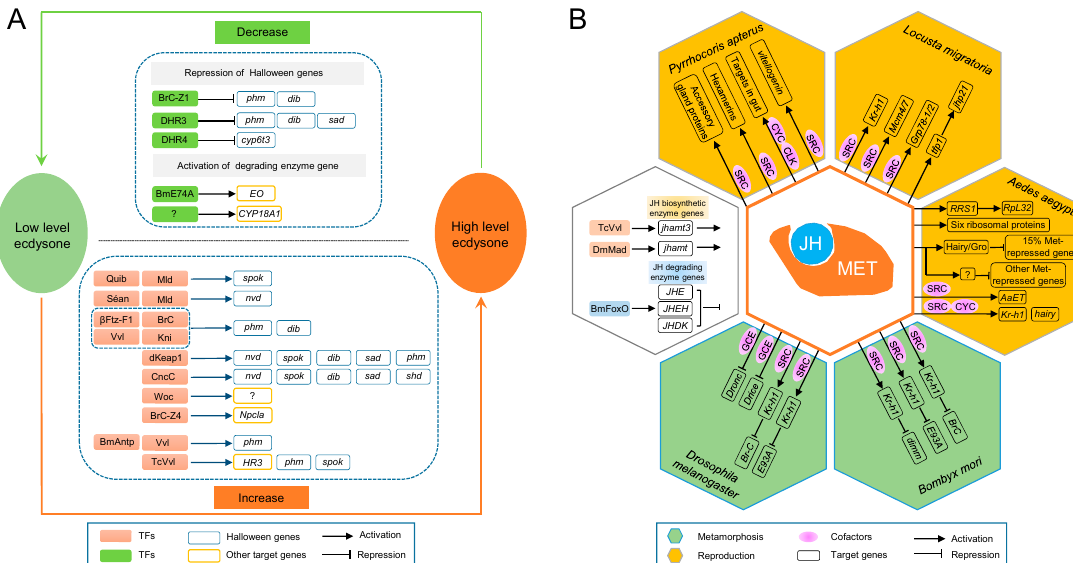
Figure 4. The 20-hydroxyecdysone (20E) and juvenile hormone (JH) signaling pathways regulating insect molting, metamorphosis, and reproduction. ( A ) Regulation of ecdysone titer by TFs. Changes in the ecdysone titers of insects are synergistically controlled by the synthesis and degradation of ecdysone. A low level of ecdysone promotes TFs to specifically regulate the Halloween genes in PG, thereby increasing steroidogenesis. A high level of ecdysone drives TFs to repress the expression of Halloween genes and activate the expression of degradative enzyme genes to directly degrade ecdysone, thus decreasing ecdysteroid titers. ( B ) Regulation of insect reproduction and metamorphosis by JH signaling pathway-related TFs. The white hexagon on the left shows TFs regulating the synthesis and degradation of JHs; the central hexagon represents JH binding to the JH receptor Met to regulate the transcription of downstream target genes; the orange hexagons display the JH/Methoprene-tolerant (Met) complex regulates downstream targets to control insect reproduction; the green hexagons indicate metamorphosis; and the purple gradient ellipses denote the cofactors of Met.